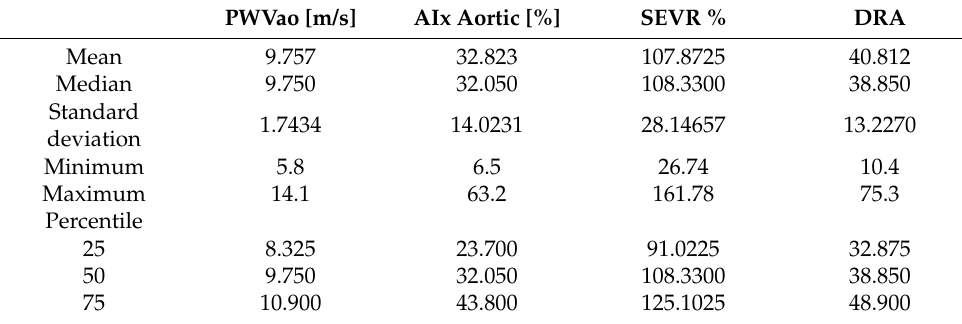
Table 3. Characteristics of arterial stiffness parameters.